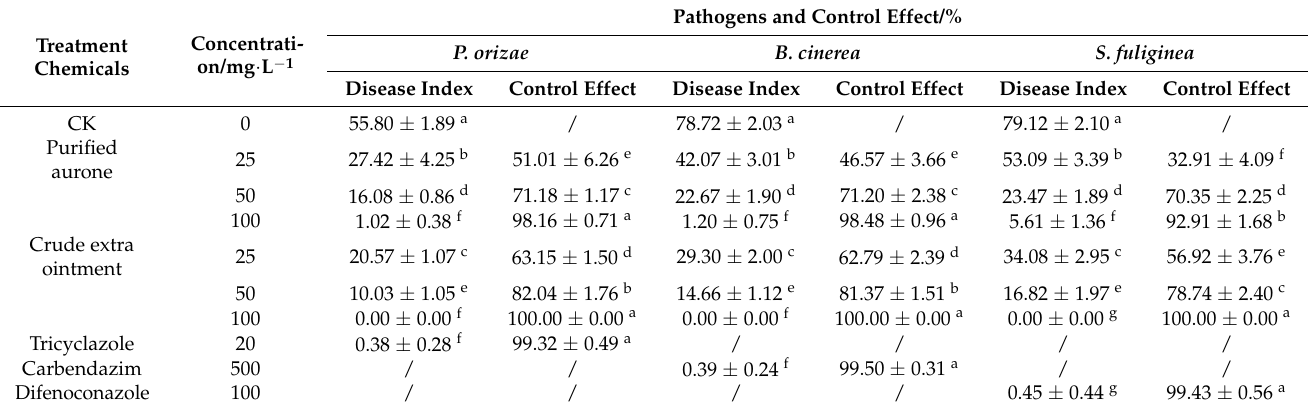
Table 7. The control effect of compounds against different disease in pot